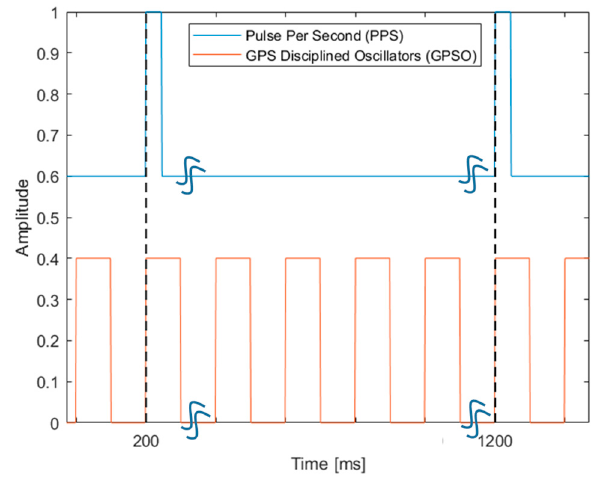
Figure 6. Example of GPS Disciplined Oscillators (GPSDO).